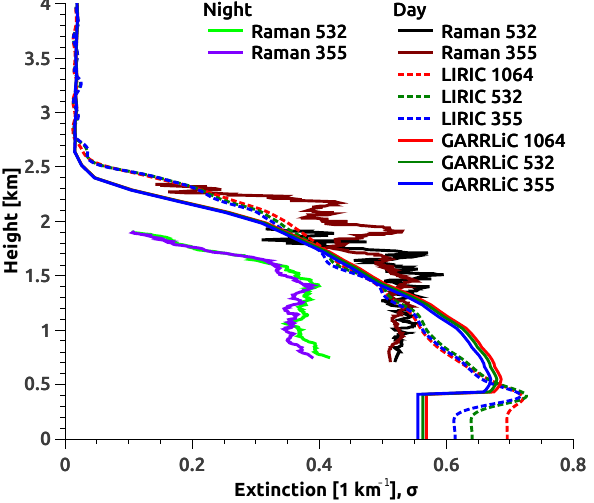
Figure 10. Lidar ratio and depolarization ratio during day- and nighttime measurements for an event on 29 March 2015 over the Dakar site. GARRLiC and LIRIC LR column-integrated values are shown at the beginning of the